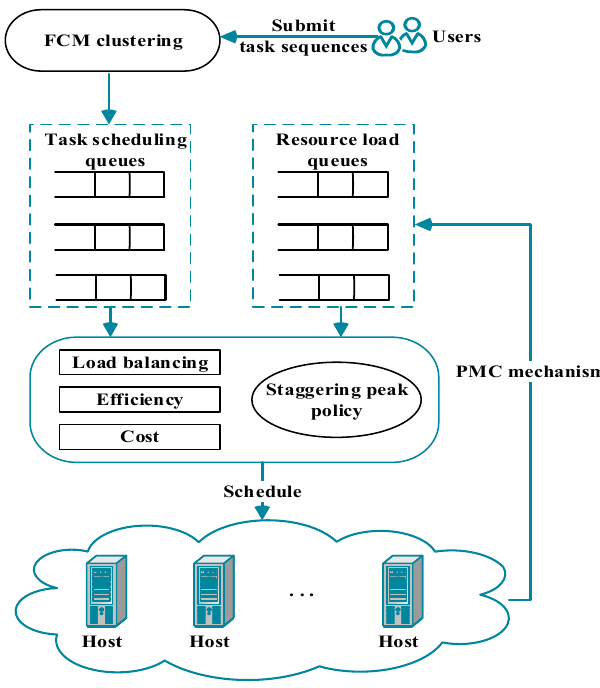
Figure 1. System framework model.